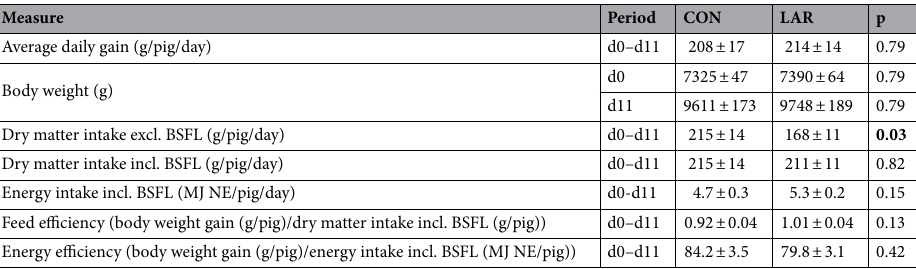
Table 4. Average daily gain, body weight, dry matter intake (excluding and including black soldier fly larvae (BSFL)), energy intake (including BSFL), feed efficiency, and energy efficiency of pigs receiving wood shavings (CON) or black soldier fly larvae (LAR) twice a day. Data are expressed as means ± SEM. Significant p-values are presented in